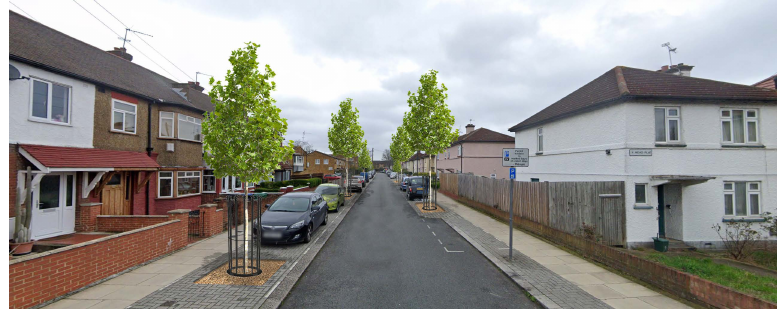
Figure 4. Stonebridge MPTs